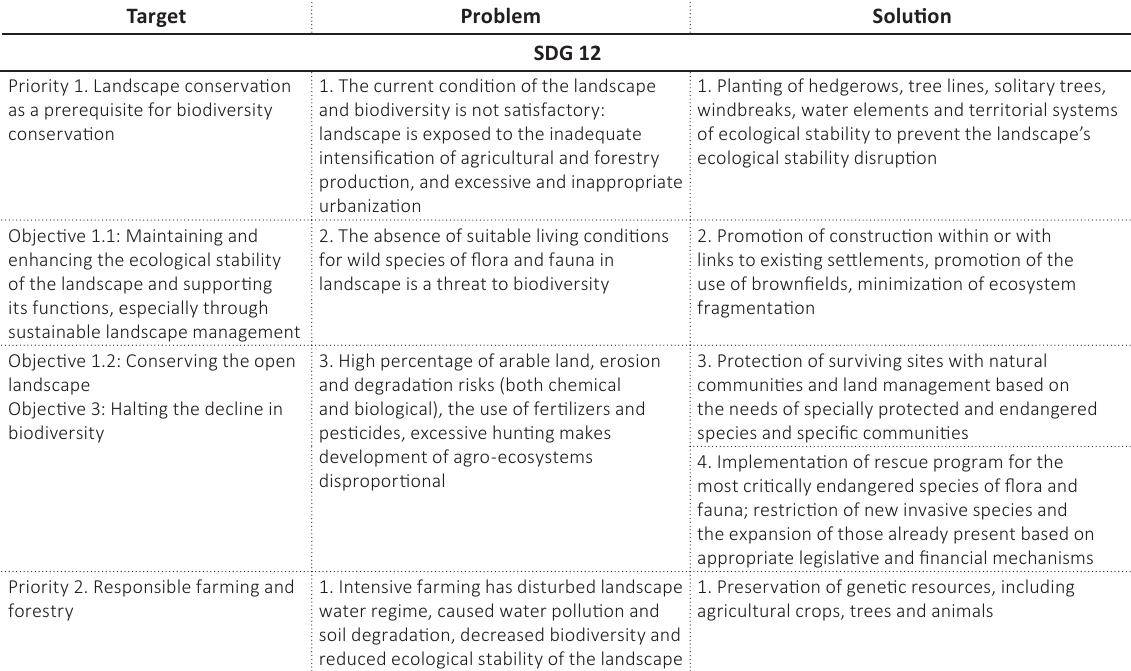
Table 6. Problems arising in the process of achieving SDGs 12 in the Czech Republic, and solutions to come up with